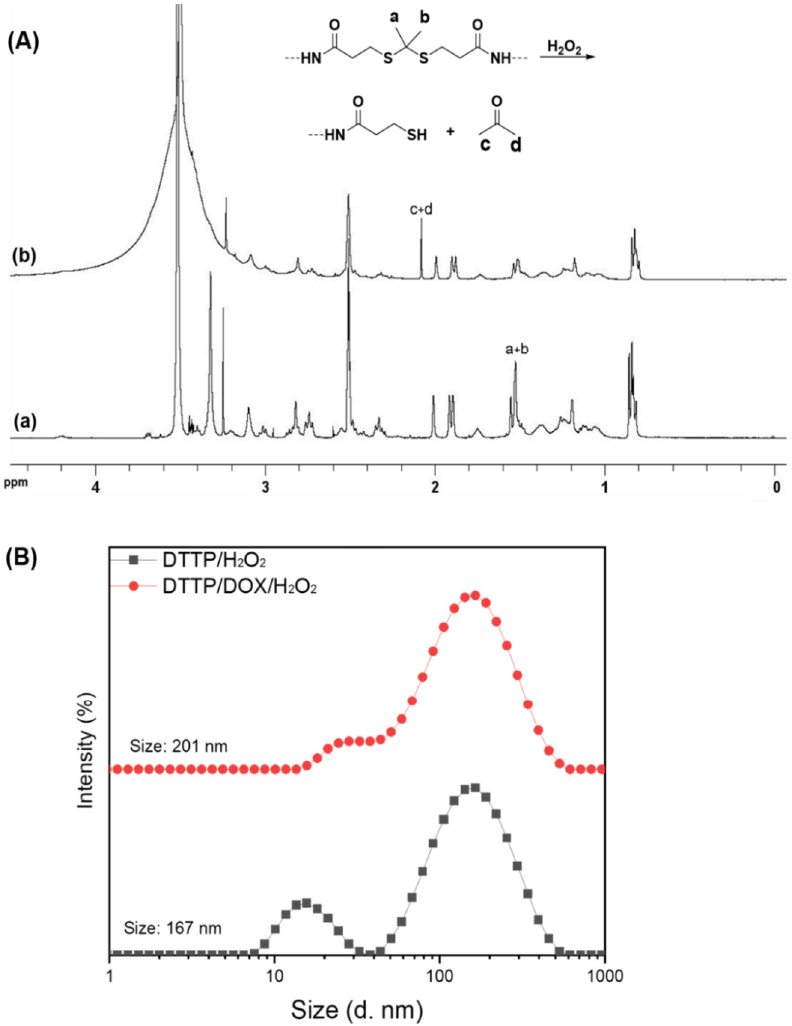
Figure 3. 1 H NMR spectra of DTTP (a) and cleaved DTTP in deuterated DMSO containing H 2 O 2 and metal tracer (CuCl 2 ) (b) ( A ). Particle size distributions of DTTP- and DOX-loaded micelles measured